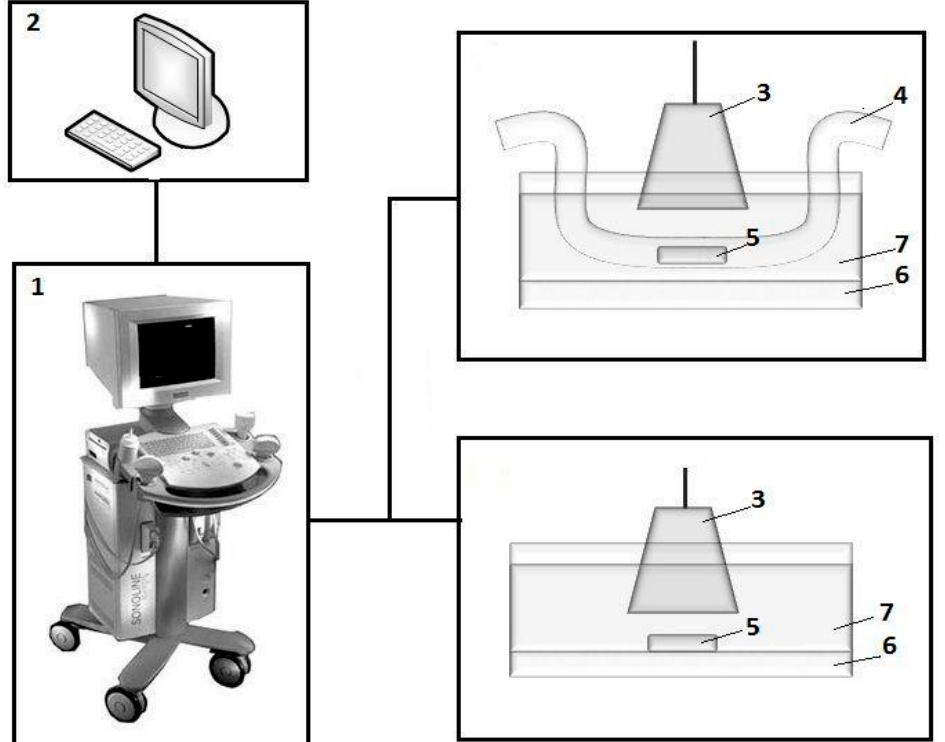
Figure 2. Scheme of the experimental setup to determine the echogenic properties of gels/ferrogels: 1—ultrasonic apparatus; 2—personal computer; 3—sensor of ultrasonic apparatus; 4—silicone tube with water; 5—sample of the gel/ferrogel; 6—soft pad; and, 7—cuvette with water. See also